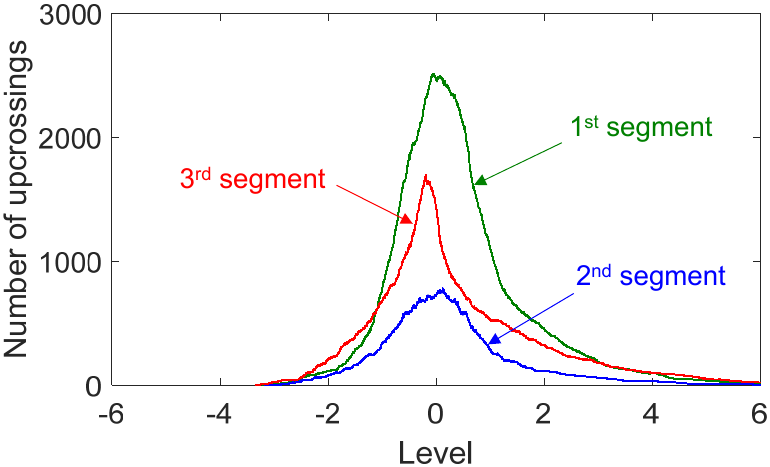
Figure 7. Comparison of level-crossing spectra from three segments of z ( t ) with duration T s = 853.3 s each (CH6 record, outer rim). Levels are normalized to signal standard deviation.